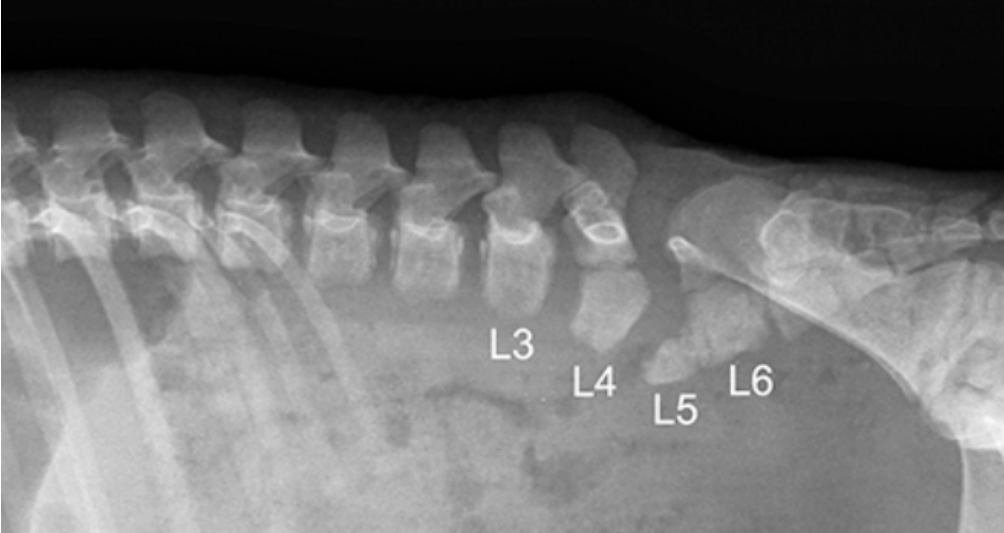
Figure 2. Latero-lateral radiograph of the lumbar tract of the Piglet #1. The last four lumbar vertebrae present a series of malformations: L3 miss the caudal ossification nucleus; L4 has a segmented and deformed body; L5 is present only as a “wedge-shaped” bud of the body; L6 is partially fused with L5 and with a dysplastic arch.